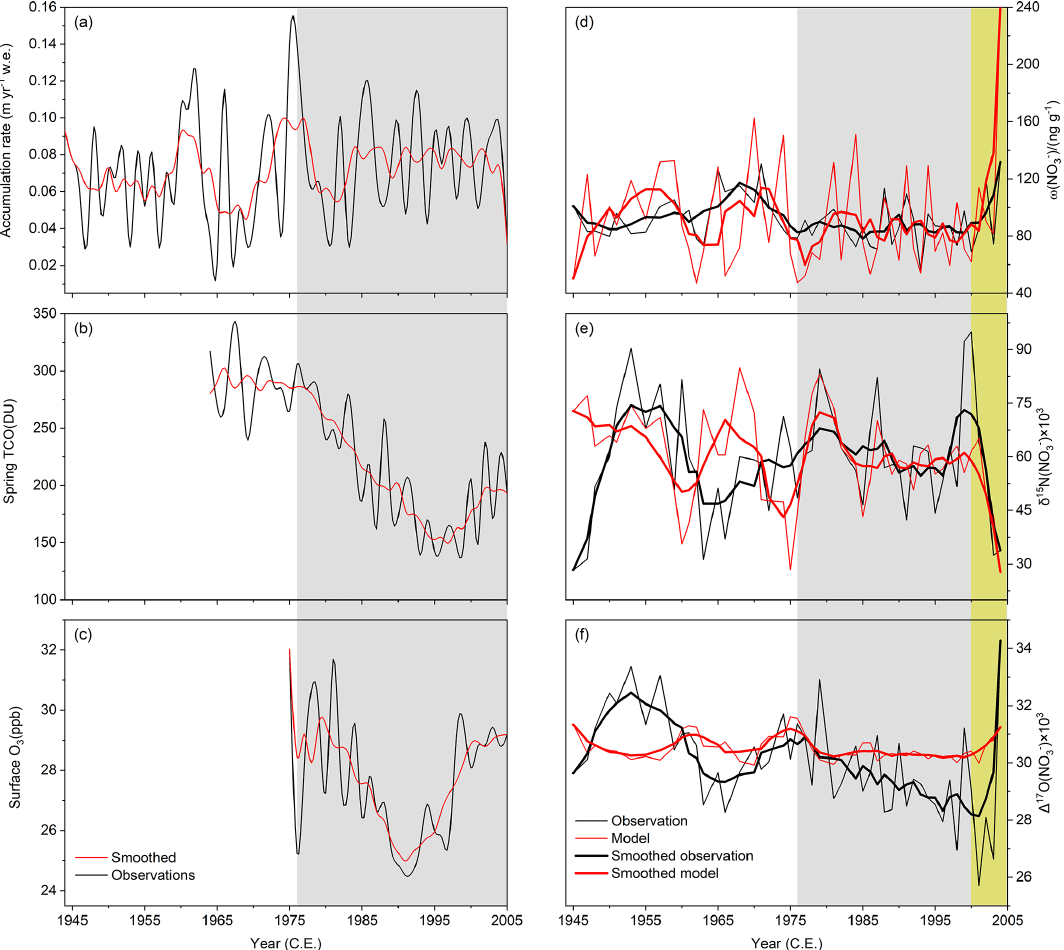
Figure 3. (a–c) Time series of annual snow accumulation rate (a) , spring (average from 22 September to 13 October) TCO (total column ozone) (b) , and summer half-year surface O 3 concentrations (c) at the South Pole over the period of the ice-core record. Red curves are the 5-year moving averages. (d–f) Ice-core nitrate concentration and isotopic compositions at the South Pole during 1944–2005 (black: observations; red: modeled). The thin lines represent the observed and modeled annual (d) ω (NO − from 1944 to 2005. The thick lines represent the 5-year moving averages. Yellow shading represents the period with changes in nitrate concentrations and isotopes from surface snow to below the photic zone. Gray shading represents the ozone hole